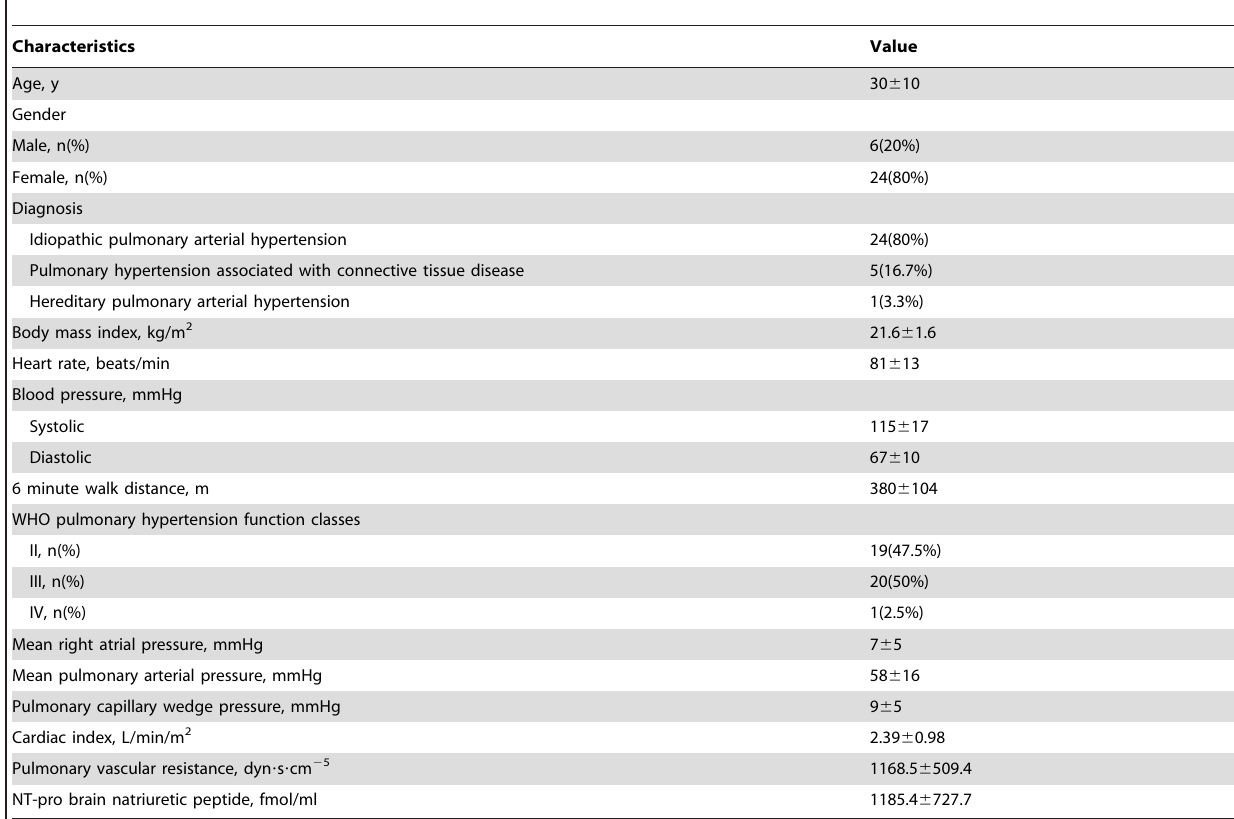
Table 1. Demographic, clinical and hemodynamic variables of patients with pulmonary arterial hypertension.